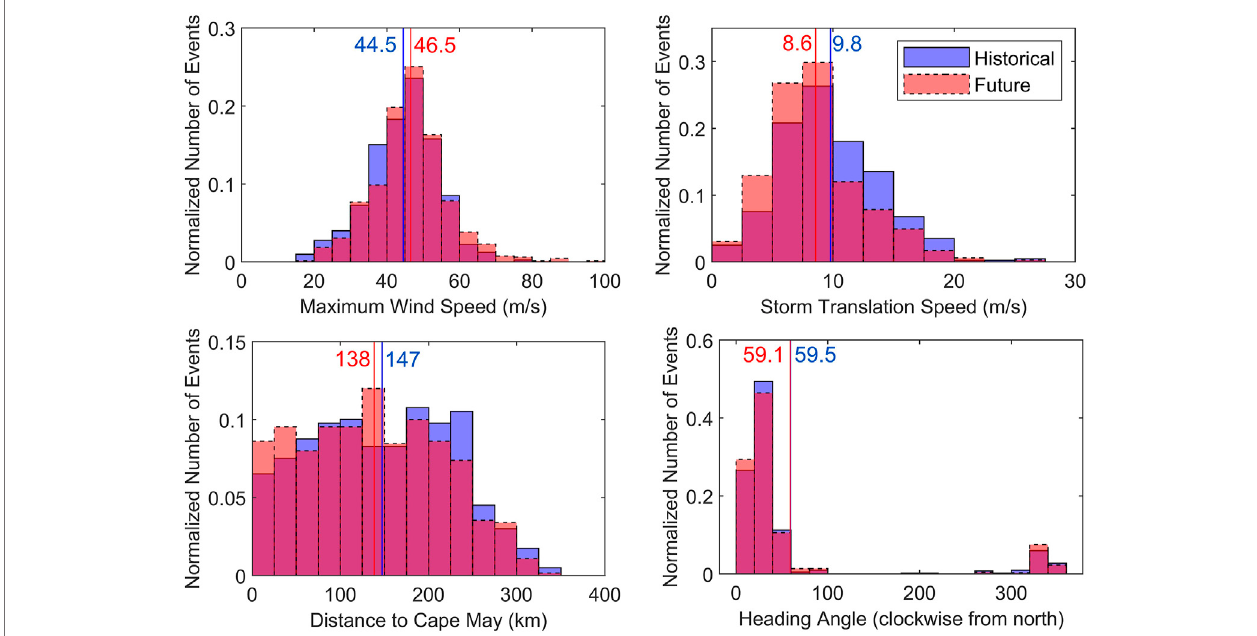
FIGURE 2| Characteristic parametersof the 399 historical and 650 future synthetic category three to fi ve hurricanes that pass within 500 kmof the southern tip of Cape May County, New Jersey when they are at their closest distance to this location. Vertical lines and their adjacent labels show the mean values (blue: historical period; red: future period).